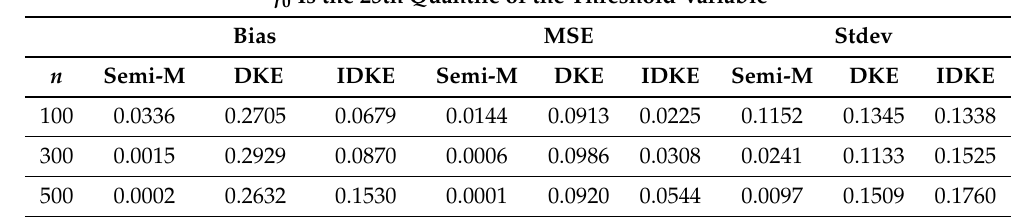
Table 1. Simulation results of nonparametric threshold estimators, Data-generating Mechanism 1 (DGP 1). IDKE, integrated difference kernel estimator.